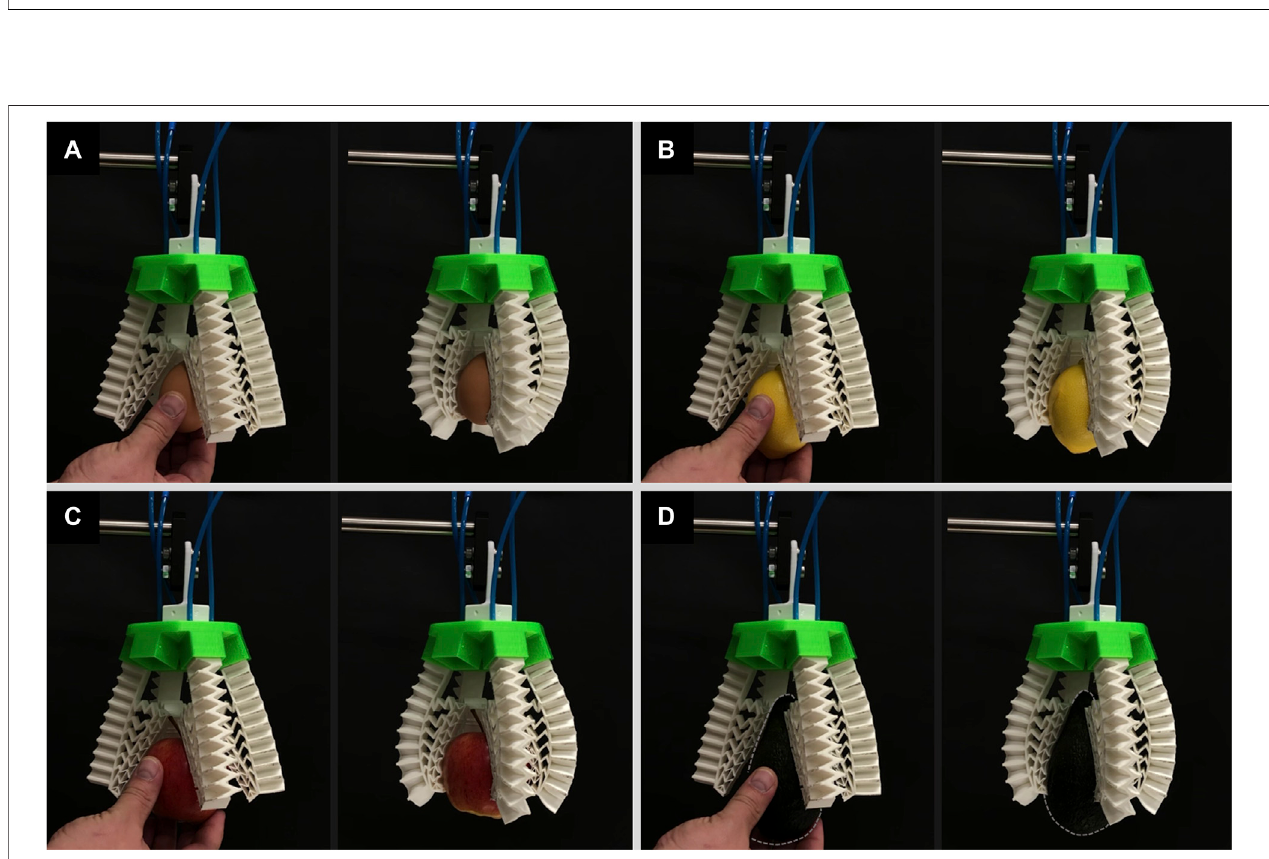
FIGURE 12 | The soft modular gripper in a four- fi nger con fi guration with the mechanical metamaterial grasping successfully (A) an egg, (B) a lemon, (C) an apple, and (D) an avocado.